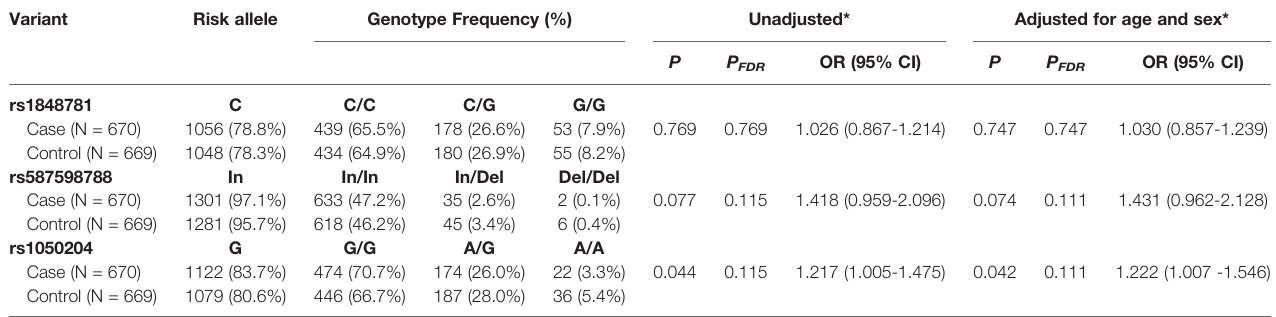
TABLE 2 | Association of FCGRIA varaints with sarcoidosis susceptibility. Variant